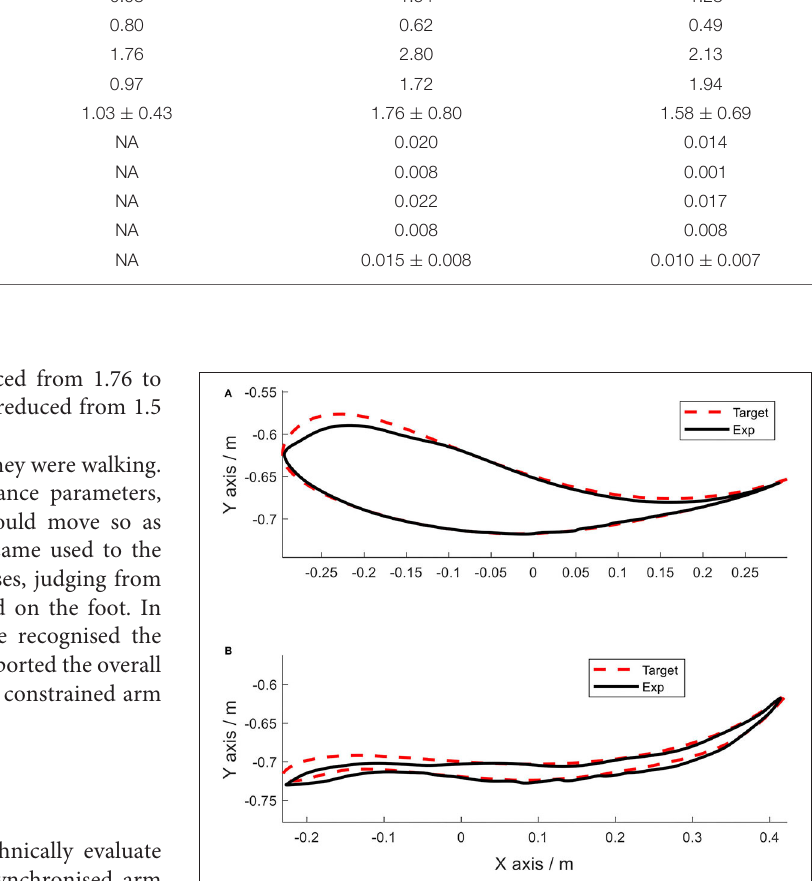
System only (low-gain parameters)